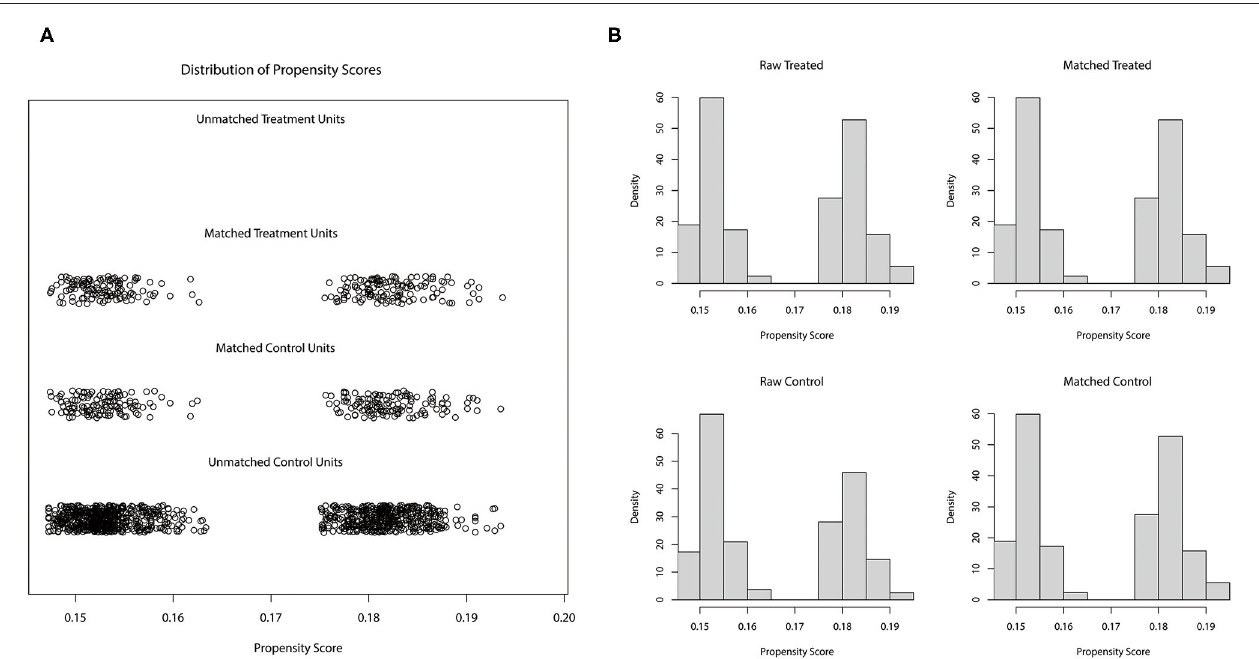
FIGURE 2 | Distribution of 1:1 propensity matching score in cluster (A) and histogram (B) match was based on demographic information included age, sex, and